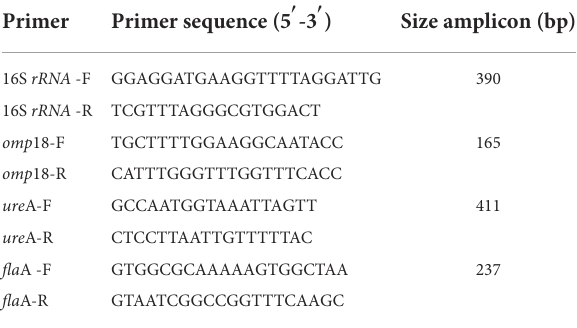
TABLE 2 Primers used for RT-PCR targeting Helicobacter pylori